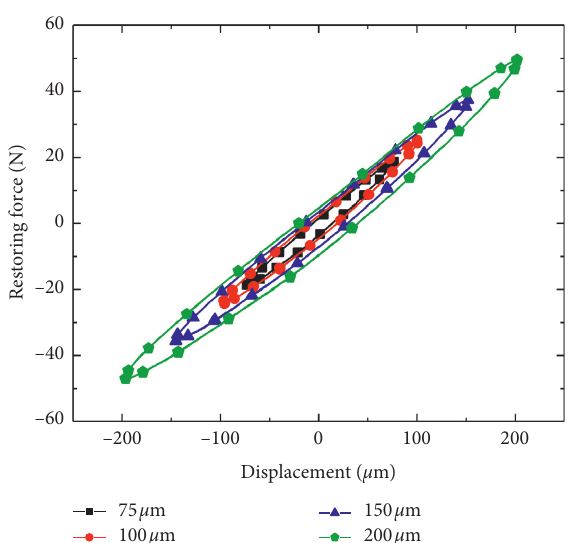
Figure 5: The expansion of hysteresis loops with respect to the change of amplitude (( f ) � 2Hz).